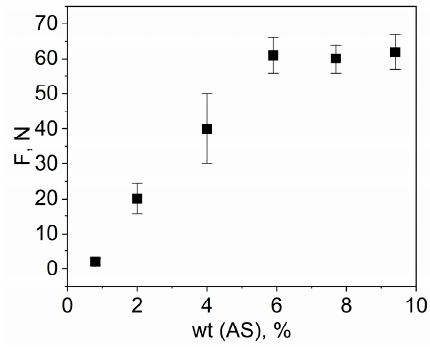
Figure 5. Dependence of the shift force on the concentration of allylsilane in the OSTE-AS polymers. The concentration of allylsilane also affected the wettability of oxide surfaces by the prepolymer and the viscosity of the prepolymer. The contact angle of the OSTE-AS prepolymer on a silicon wafer (with a natural oxide) decreased with increasing